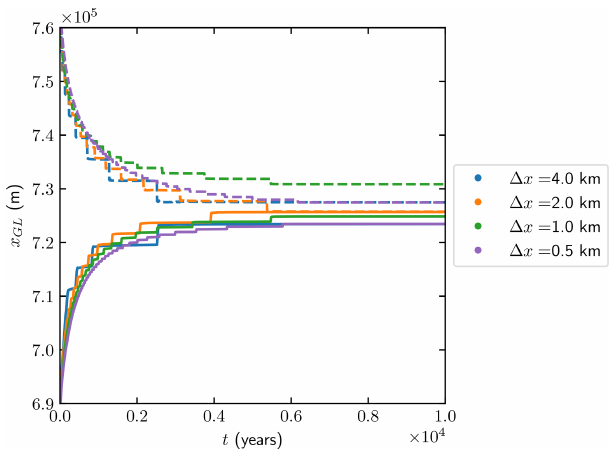
Figure 5. The MISMIP 3a experiments for the GL position when t ∈ [ 0 , 10000 ] with (cid:49)x = 4, 2, 1, and 0 . 5km for the advance (solid) and retreat (dashed) phases.